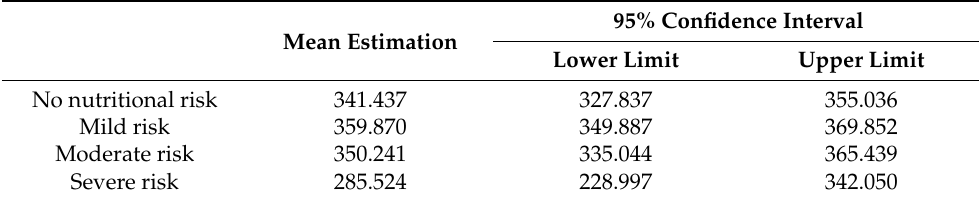
Table 6. Survival mean (days) using the Kaplan-Meier analysis based on nutritional status estimated by CONUT. Analysis with the nutritional estimate using CONUT at hospital admission.